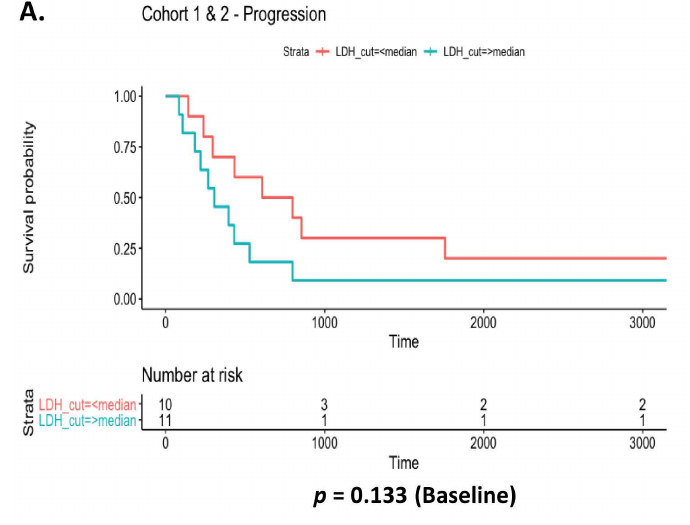
Figure 7. Prognostic significance of the systemic inflammatory markers NLR and dNLR. Systemic inflammatory markers (NLR and dNLR) were correlated with time to progression and overall survival at baseline ( A , B ), 3 months ( C , D ) and 6 months ( E , F ). The median cut-offs for NLR and dNLR at each of the three time-points were ≥ 5.37 and ≥ 3, ≥ 3.42 and ≥ 2.28, and ≥ 4.64 and ≥ 2.17, respectively. Univariate Cox proportional hazards analysis of time to progression and overall survival was used and Kaplan Meier survival plots represented (* p <